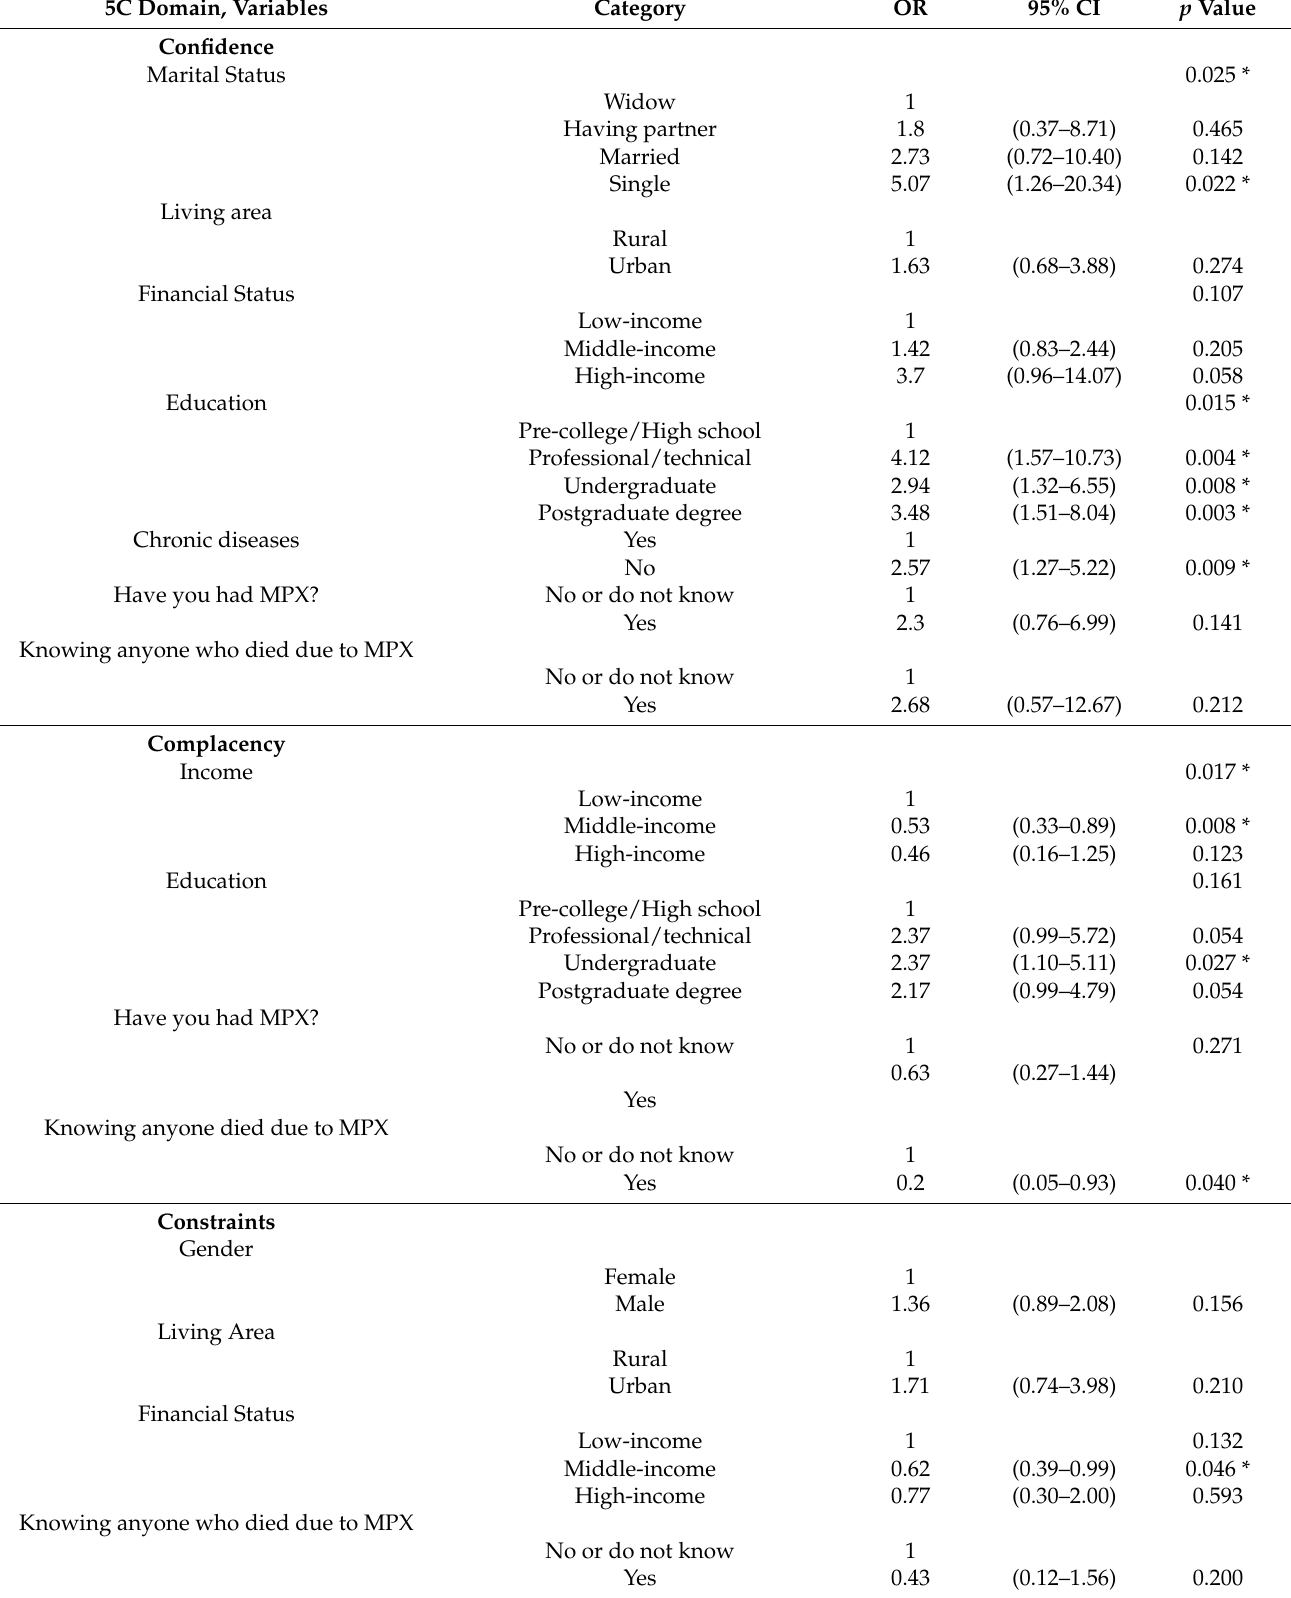
Table 3. Determinant of the 5C psychological antecedent of monkeypox vaccination among Nigerian healthcare workers in the study